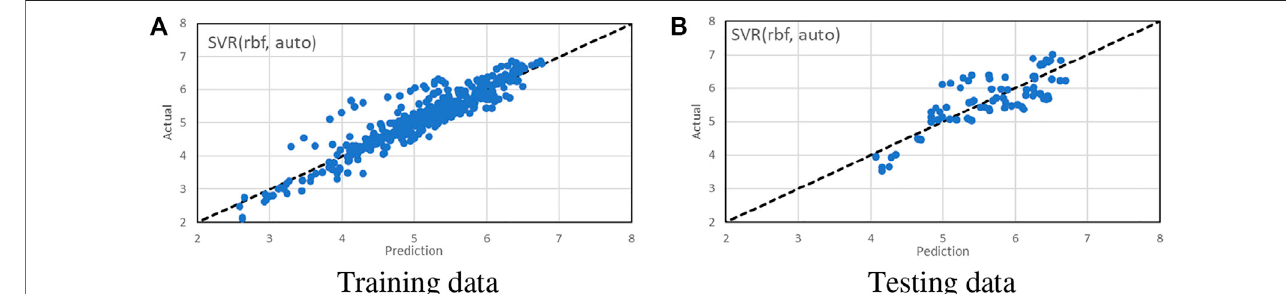
FIGURE 6 | Actual vs. prediction of SVR (rbf, auto) model.